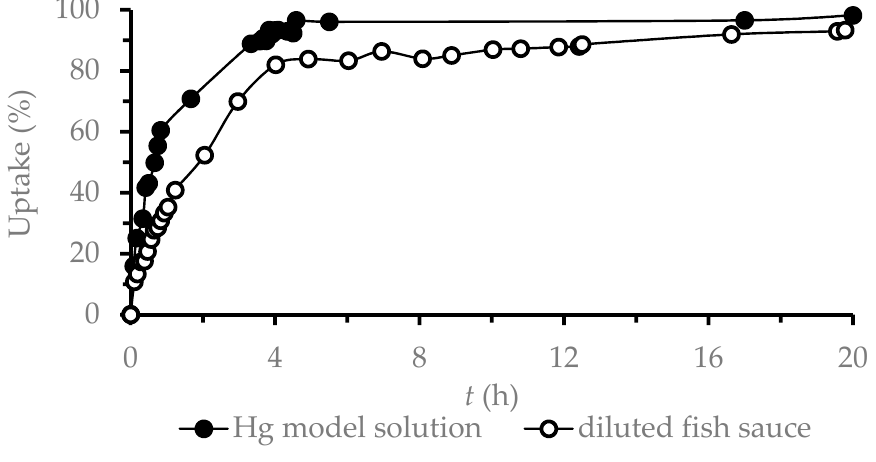
Figure 3. Uptake e ffi ciency of Hg (1 mg · L − 1 ) on the binding Figure 3. Uptake efficiency of Hg (1 mg·L − 1 ) on the binding gel.